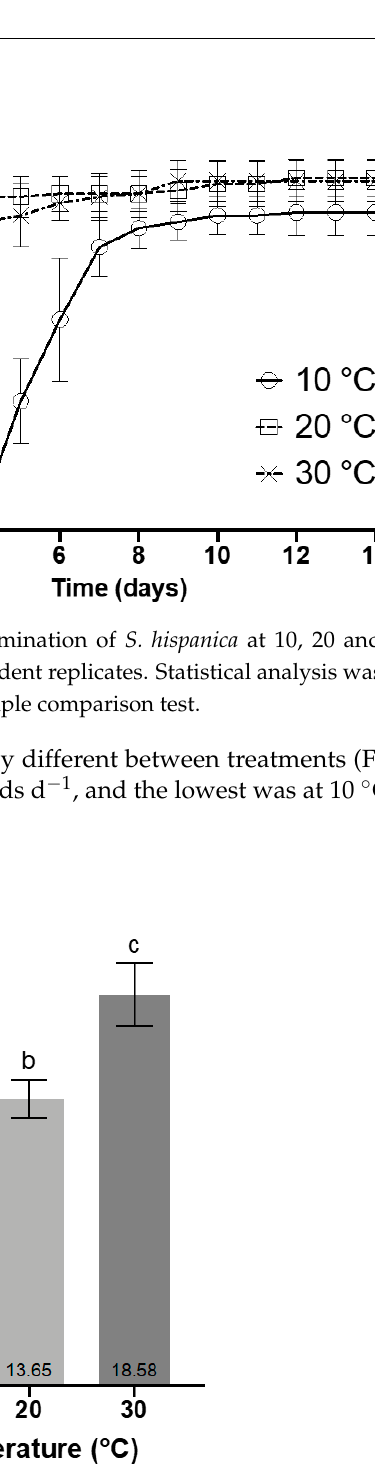
Figure 3. Germination rate (number of germinated seeds per day) at 10, 20 and 30 ◦ C. Values are expressed as mean ± SD of five independent replicates. Statistical analysis was performed using Kruskal-Wallis followed by a Dunn’s multiple comparison test. Different letters indicate significant differences ( p <